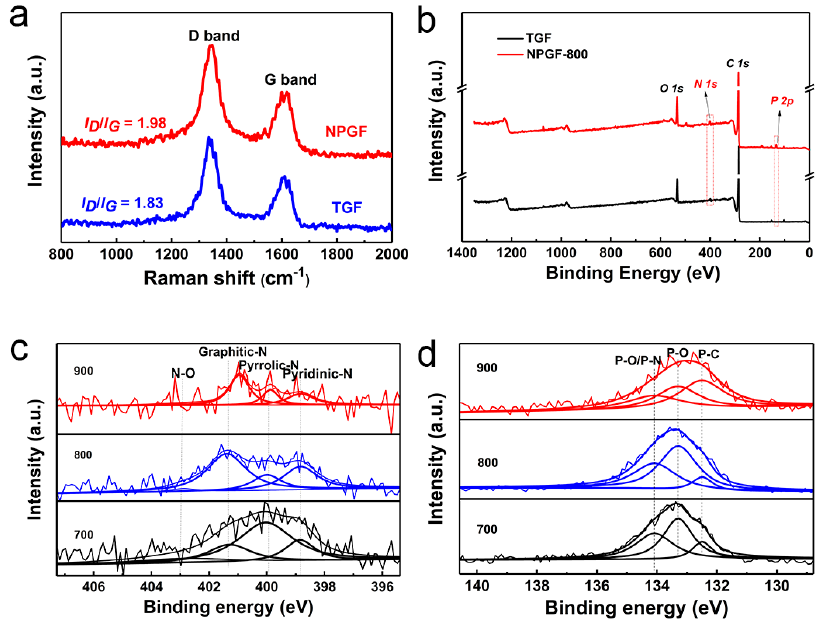
Figure 2. Characterization of the microstructure and element composition of the electrode materials. ( a ) Raman spectroscopy of TGF and NPGF electrode materials. ( b ) Xray photoelectron spectroscopy survey spectra of TGF and NPGF-800 samples; ( c , d ) high resolution of N 1s and P 2p spectra of NPGF prepared by a different annealing temperature.